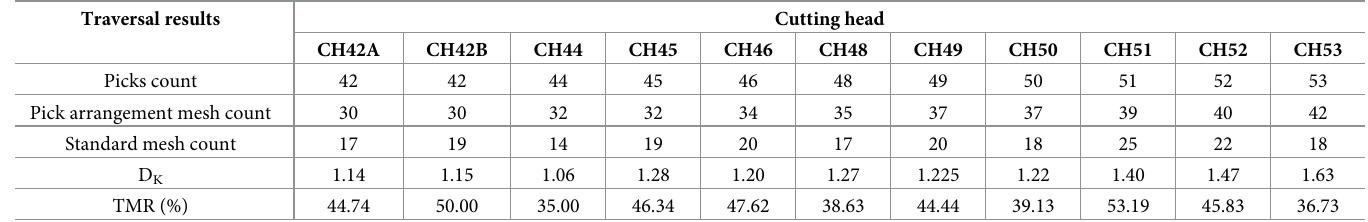
Table 3. Recalculated results without interference.